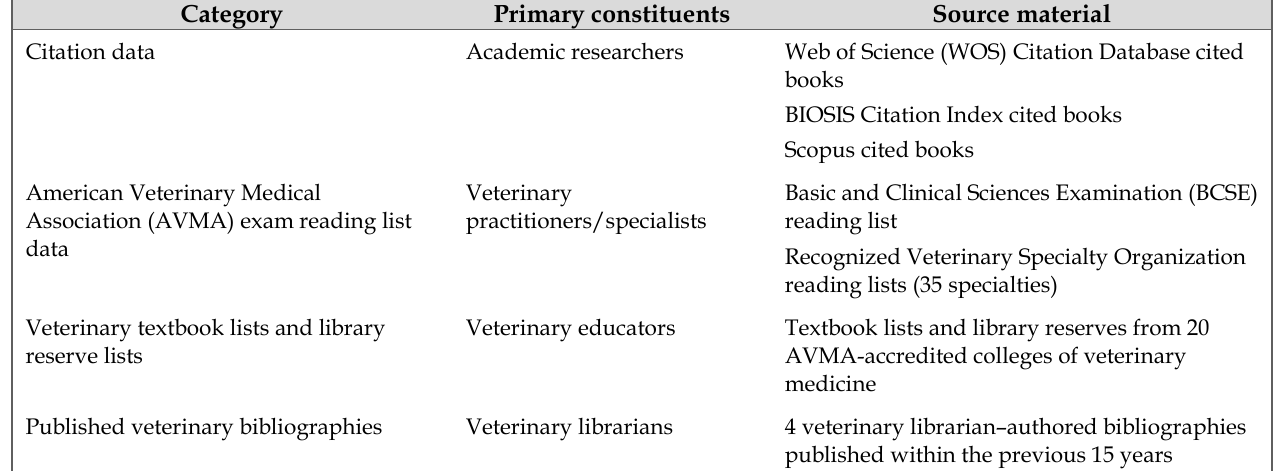
Table 1 List of categories, the type of expert opinion they represent, and source material